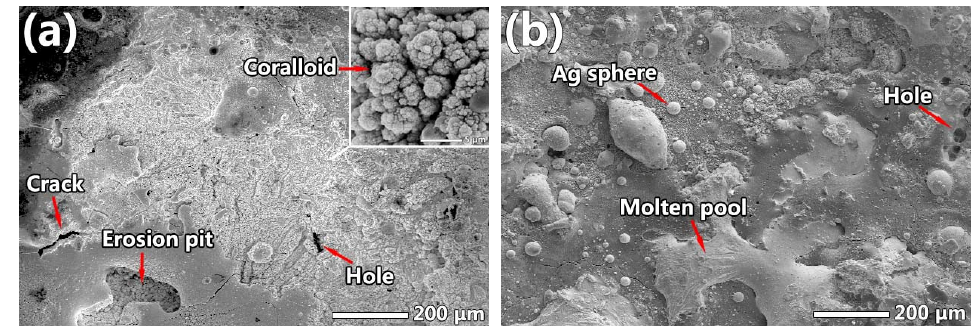
Fig. 8 (a) Primary micro-morphologies on the contact surface of Ag/CdO, where cracks, erosion pits, and holes were clearly observed. (b) Molten pool and the large Ag